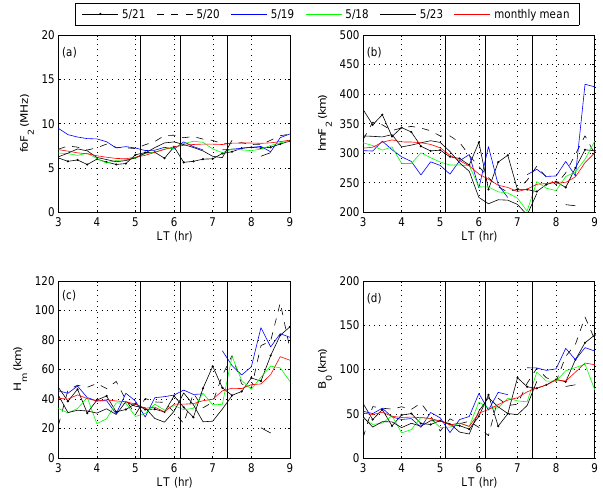
Fig. 3. The detailed variations in (a) fo F 2 , (b) hm F 2 , (c) H m , and (d) B 0 parameters from 03:00LT to 09:00LT on 21 May 2012. The dotted, green, blue, dashed, solid, and red solid lines show the vari- ation on 21, 18, 19, 20, and 23 May and the monthly mean, respec- tively. The vertical solid lines represent the onset, second contact, and ending time of the annular solar